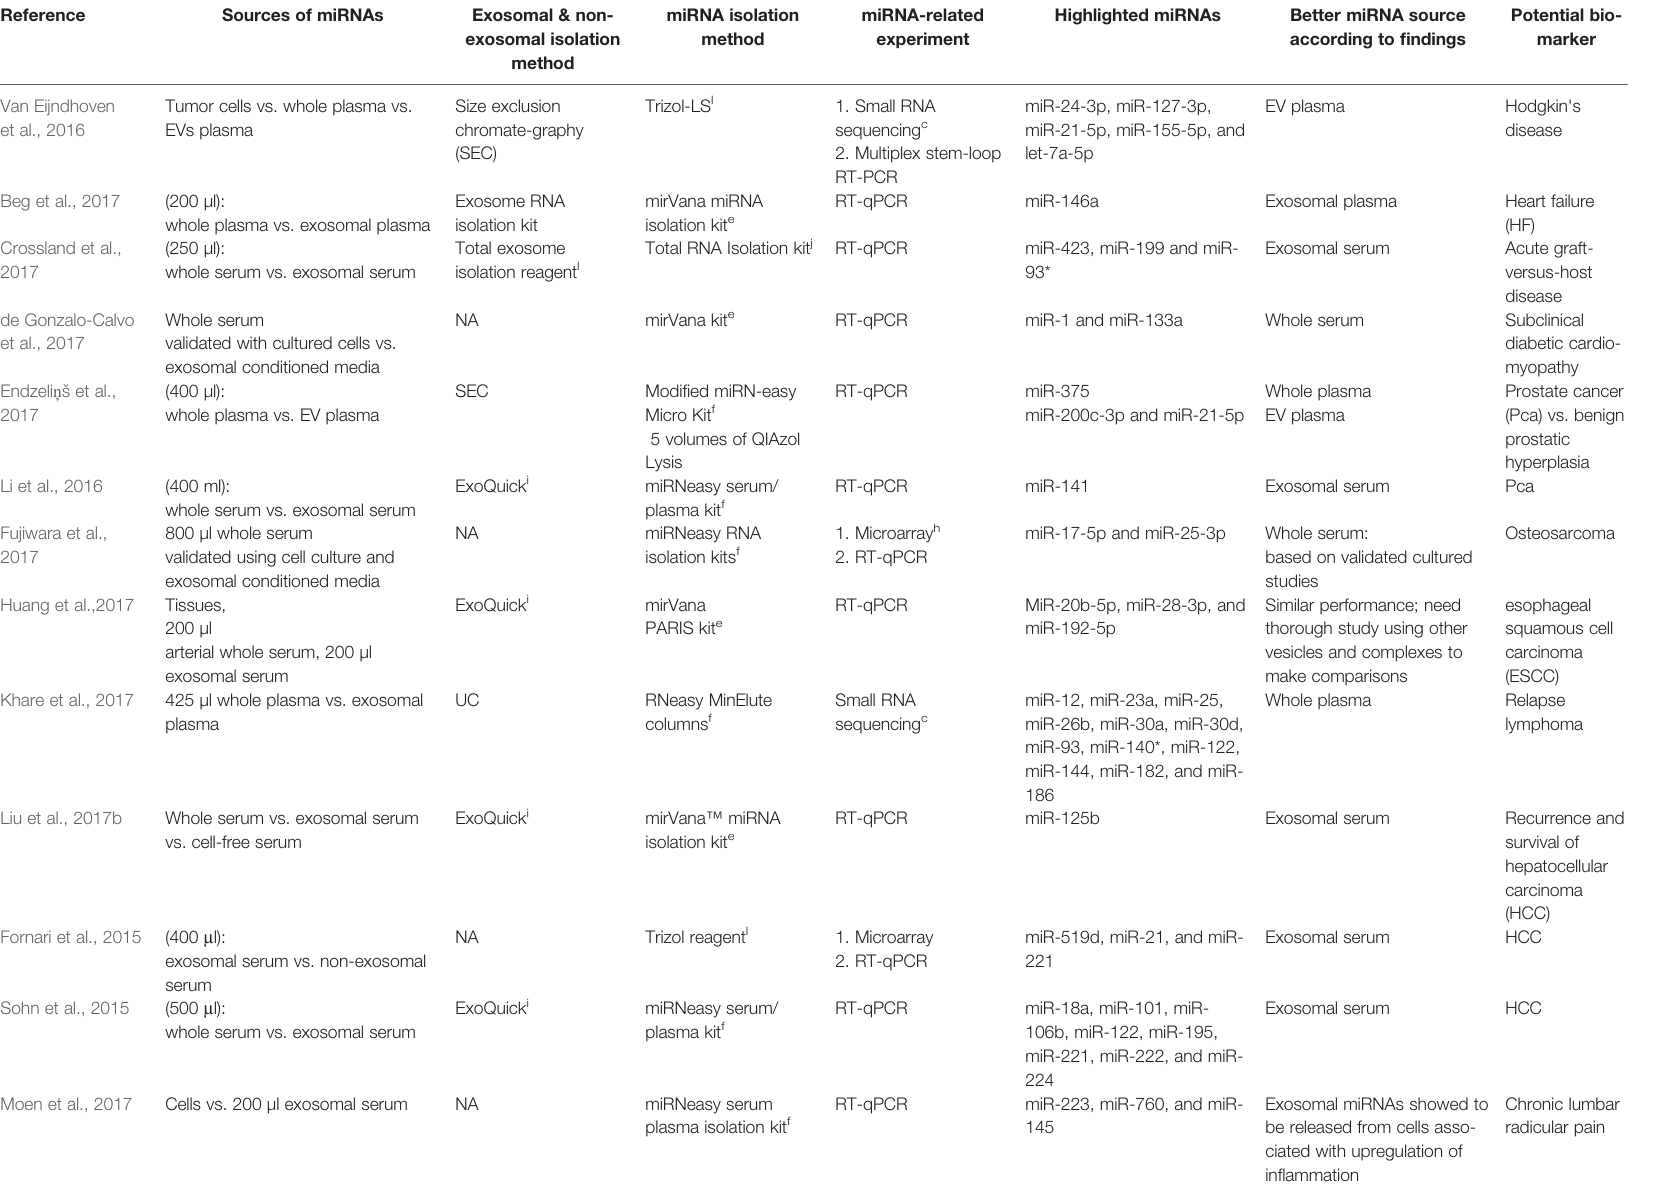
TABLE 3 | Summary of articles with comparable performance between exosomal, non-exosomal circulating miRNAs, and unfractioned miRNA samples as potential